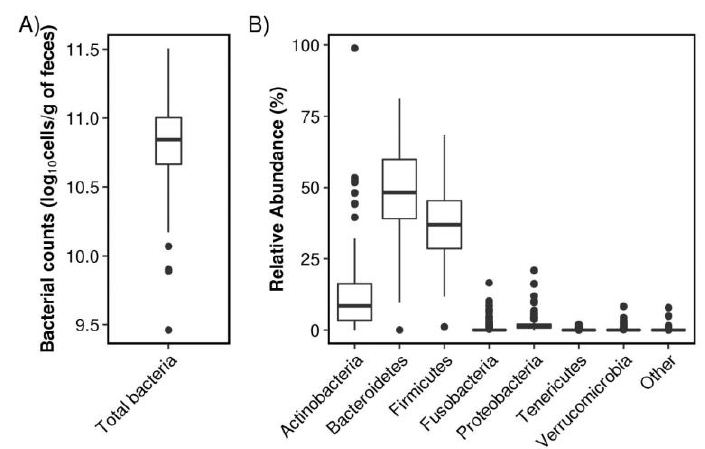
Figure 1. Gut microbiota of the subjects in this study. ( A ) Total gut bacterial counts. ( B ) Abundance of bacteria at the phylum level.